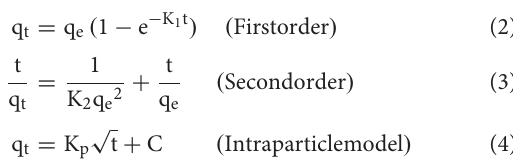
respectively. V is the volume of reaction system (L), and m is the mass of adsorbent (g).